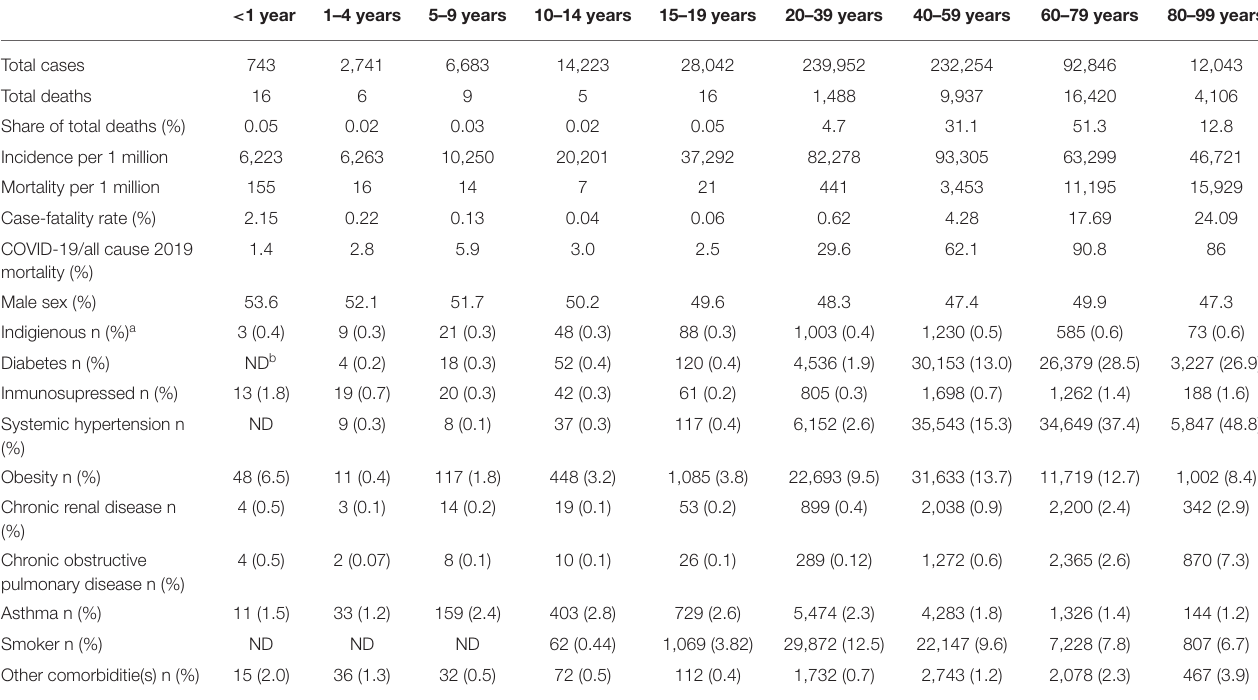
TABLE 1 | Cases, deaths, and comorbidity frequencies by age group in Mexico City from February 22nd to April